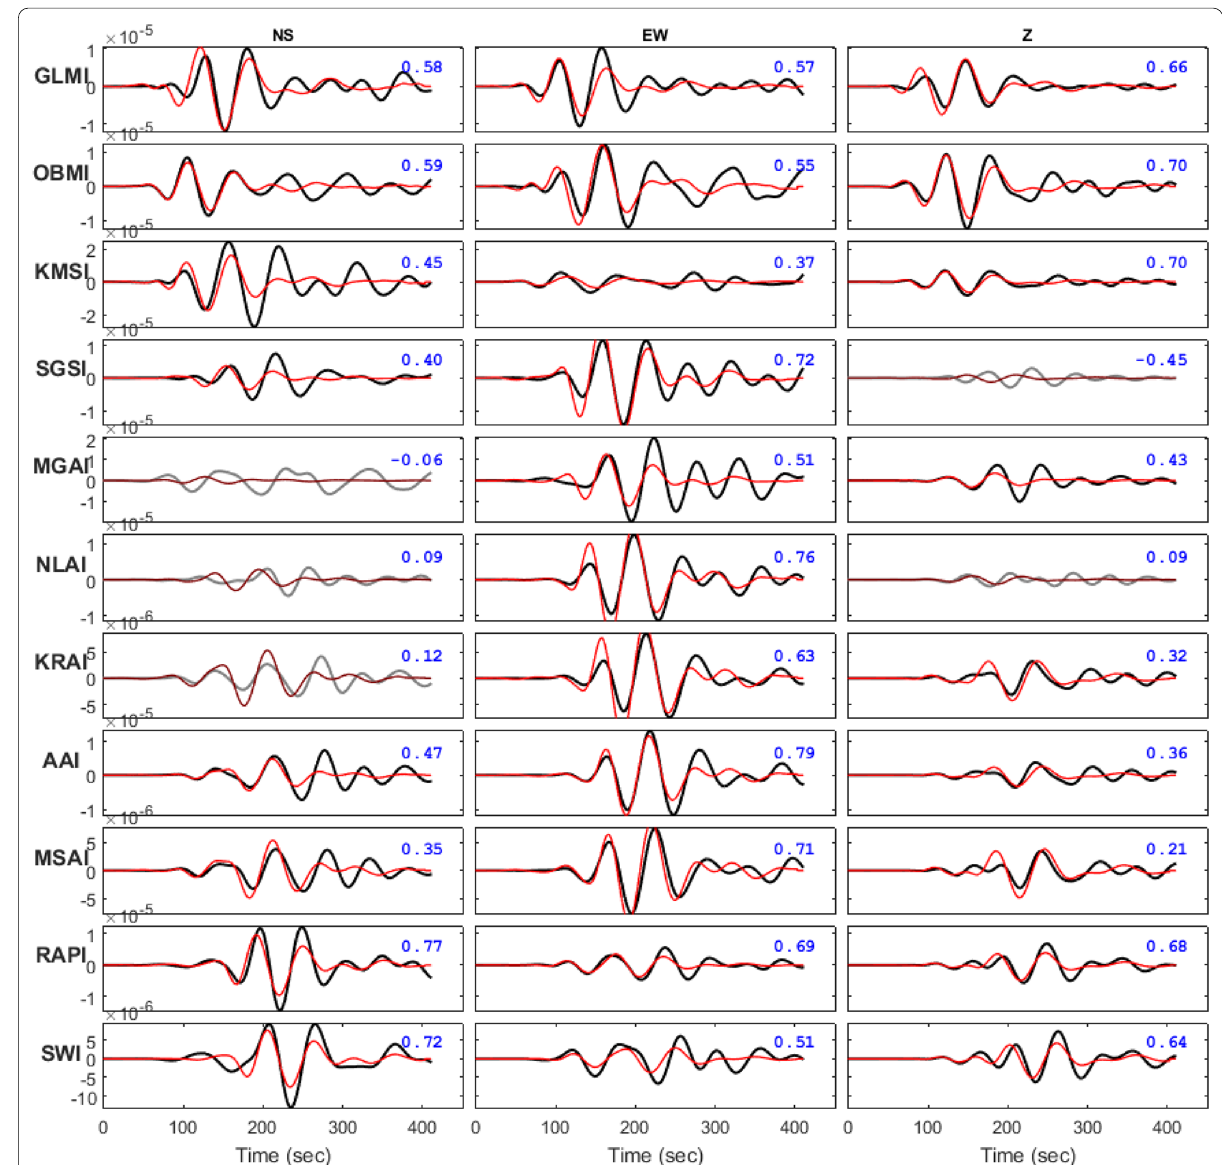
Fig. 4 Example of waveform fit for earthquake of July 8, 2019, at 06:20:16 UTC (event #6). The black and red lines represent the observed and synthetic seismograms, respectively. The gray lines indicate components that are not included in the analyses. Blue numbers show the VR of the individual